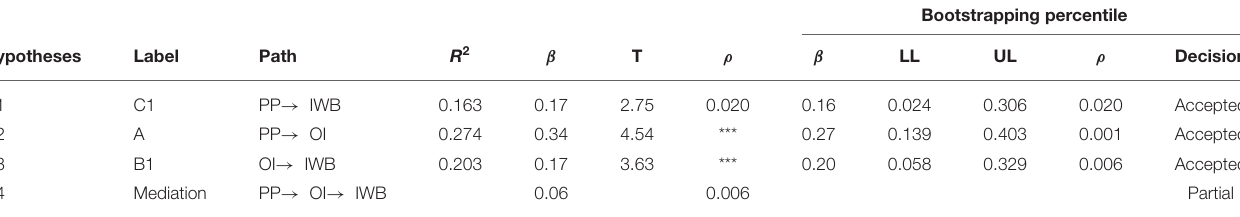
TABLE 8 | Hypothesis testing.